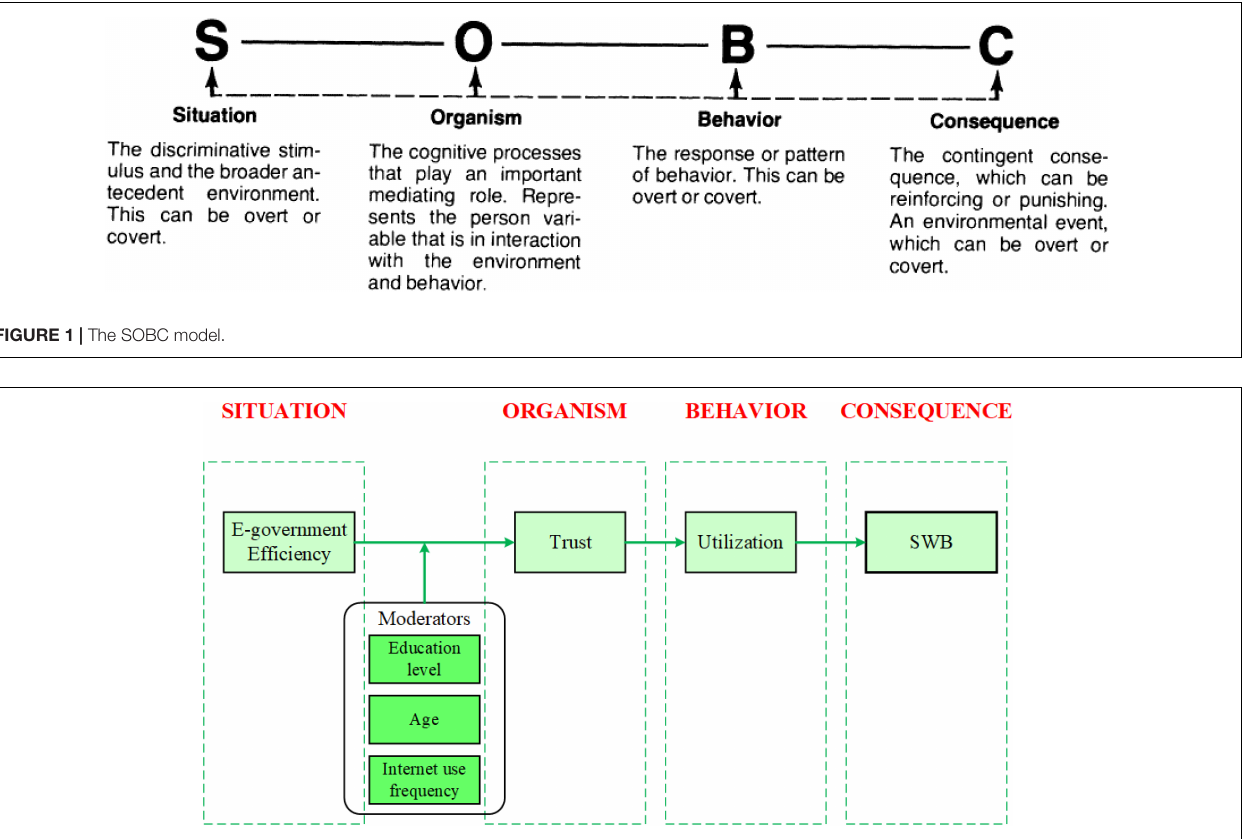
FIGURE 2 | Research